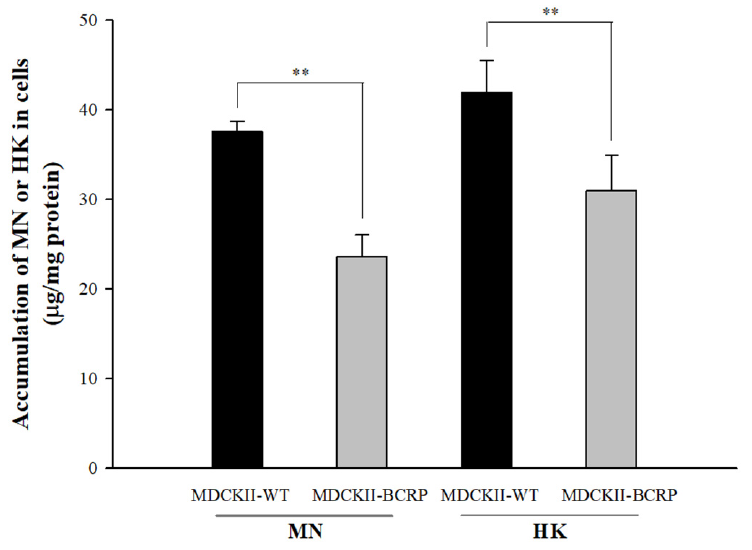
Figure 3. Intracellular accumulations of MN (100 µM) and HK (100 µM) in MDCKII-WT and MDCKII-BCRP cells after incubation for 30 min determined by HPLC-UV analysis and corrected with protein contents. ** p < 0.01.